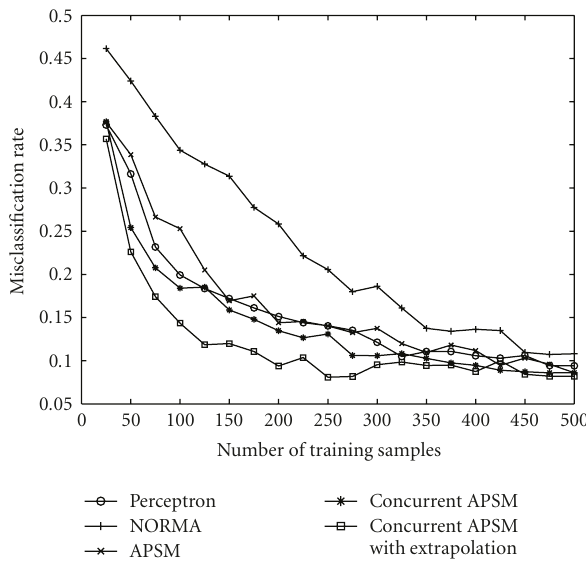
Figure 5: Tracking performance for the channel in Figure 3 when the LTI system is H 1 . We let card( J n ) : = 16, for all n . The variance of the Gaussian kernel takes the value of σ 2 : = 0 . 5. The APSM(a) refers to Algorithm 1 while APSM(b) refers to Algorithm 3. The radius of the closed ball is set to δ : = 2. The bu ff er length L b : = 500, and α : = 0 . 5.